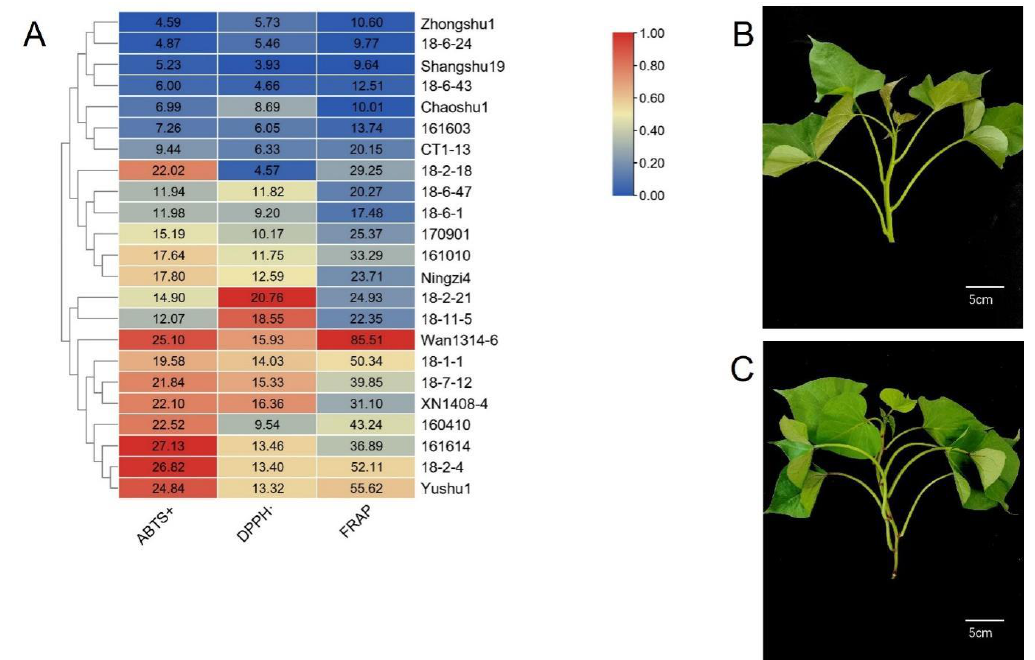
Figure 1. ( A ) Heatmap of antioxidant activity of blades from 23 sweetpotato genotypes. ( B ) Low antioxidant activity genotype ‘Shangshu 19’. ( C ) High antioxidant activity genotype ‘Wan1314-6’. Note: The values in Figure ( A ) are the measured antioxidant activity values. Heatmap production with reference to the maximum value of each column. In the figure, ‘Shangshu19’ and ‘Wan1314-6’ are used for RNA-seq. ABTS+: 2’-azinobis-(3-ethylbenzothiazoline-6-sulphonic acid) free radicals; DPPH · : 2,2-diphenyl-1-picrylhydrazyl; FRAP: Ferric ion reducing antioxidant power.